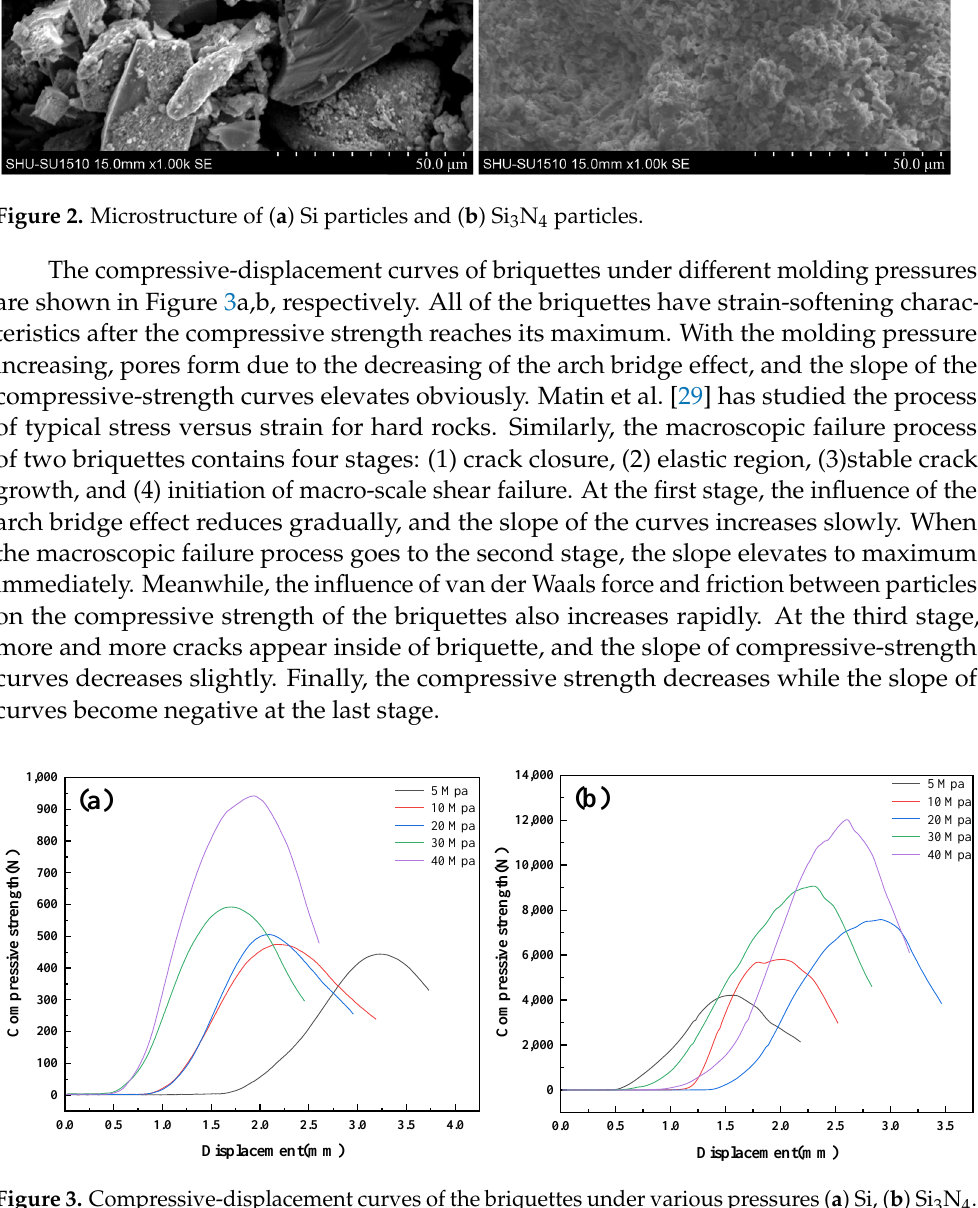
Figure 3. Compressive-displacement curves of the briquettes under various pressures ( a ) Si, ( b ) Si 3 N 4 .